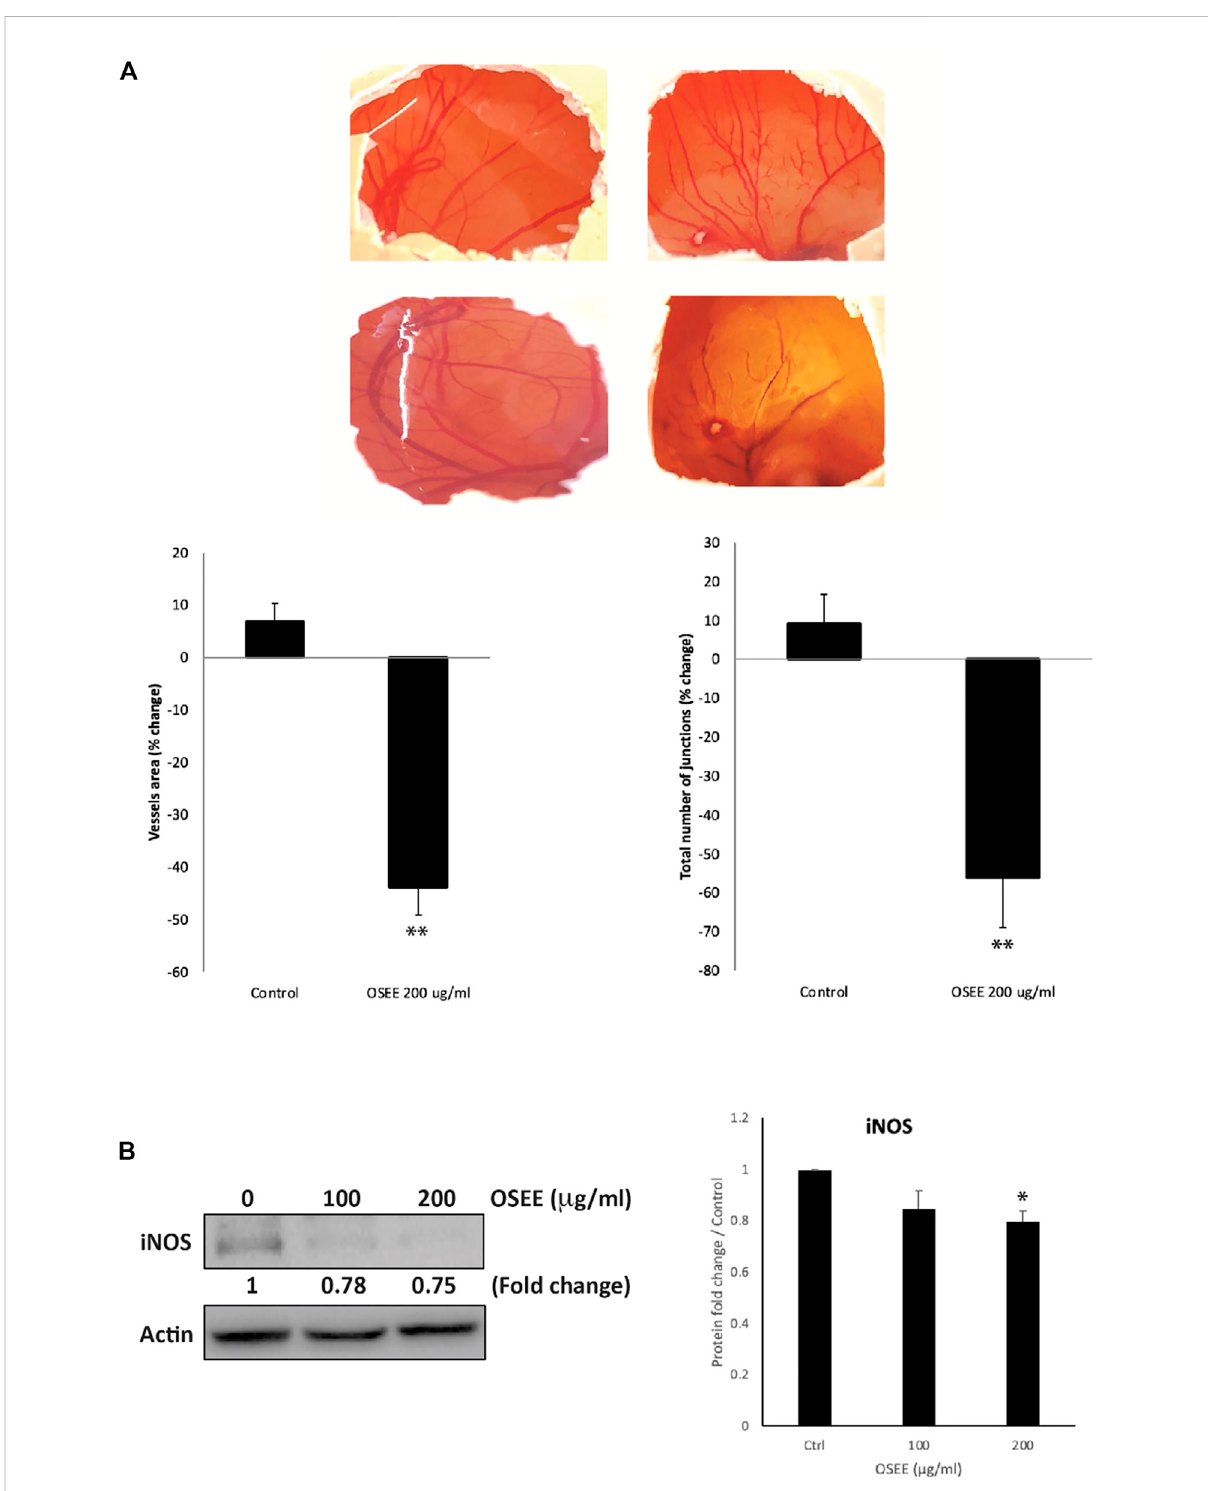
FIGURE 10 O. syriacum inhibitsangiogenesis in ovo and reduces iNOS levels inMDA-MB-231 cells. (A) OSEE was applied to the chorioallantoic membrane (CAM) of fertilized chicken eggs as described in Materials and Methods. Upper panel of (A) shows images of CAM acquired 24 h later to score the angiogenic response. Lower panel of (A) shows analysis of the acquired images. Total vessel length and total number of junctions were quanti fi ed in both the OSEE-treated and control CAMs using the AngioTool software and represented as percentage change with respect to the control (* denotes p < 0.05 and ** p < 0.01). (B) The protein levels of iNOS were determined by Western blotting in MDA-MB-231 cells treated with or without the indicated concentrations of OSEE for 24 h. The Western blot is representative of three independent experiments. The bar graph represents the quanti fi cation of three independent Western blots and the data represent the mean ± SEM of three independent experiments ( n = 3). * p <